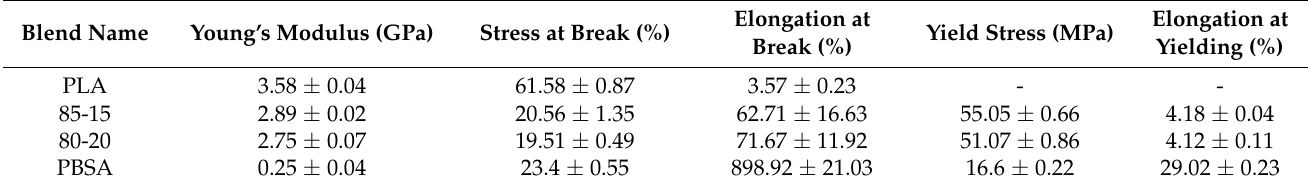
Table 2. Tensile tests